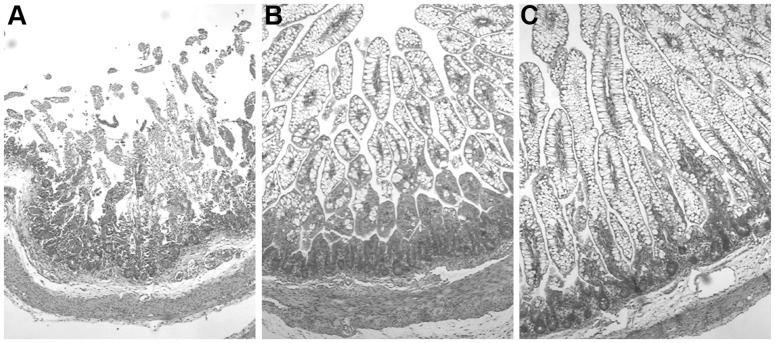
Representative micrographs of the small intestine cross sections.
Panel A: untreated, NEC score  =  3. Panel B: untreated, NEC score  =  2. Panel C: AB, NEC score  =  1.